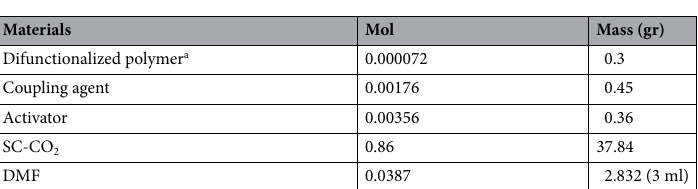
Table 2. Amount of raw materials used in the synthesis of cPNIPAAM in SC-CO 2 and co-solvent of DMF. a Difunctionalized polymer was synthesized in condition of P = 23 MPa during 12 h, T = 70 ◦ C , W W t /W i = 83.3%, M w = 4165 (gr/mol), M n = 1488 (gr/mol) PDI = 2.8, and Mp = 1039 (gr/mol).